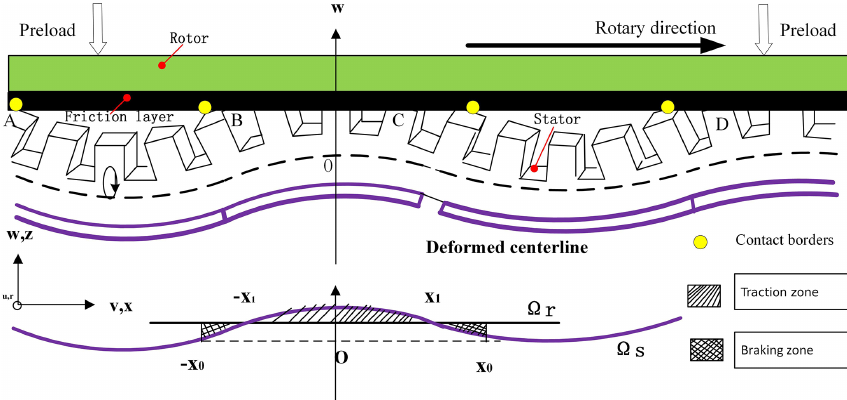
Figure 4. The contact schematic of the TWUSM.